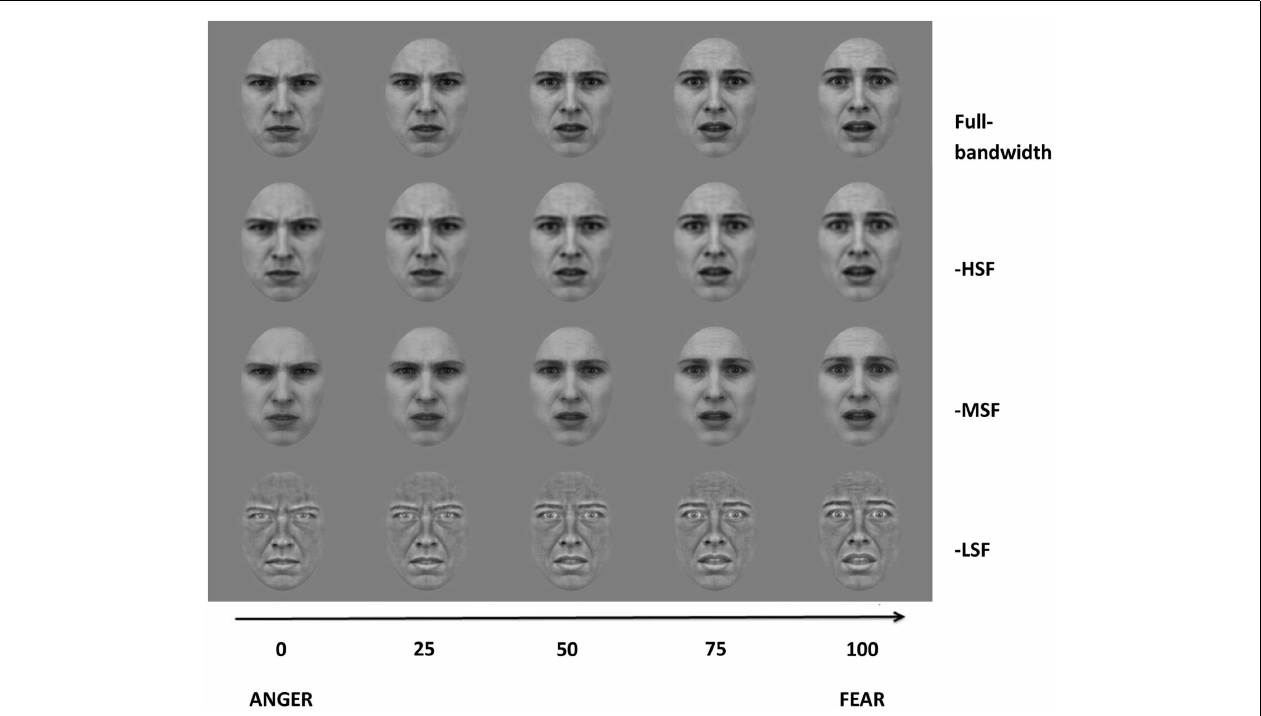
FIGURE 1 | Image examples from the four morph continua (Full-bandwidth, -HSF, -MSF, and -LSF) .The abscissa represent the degree of morphing of the corresponding images.